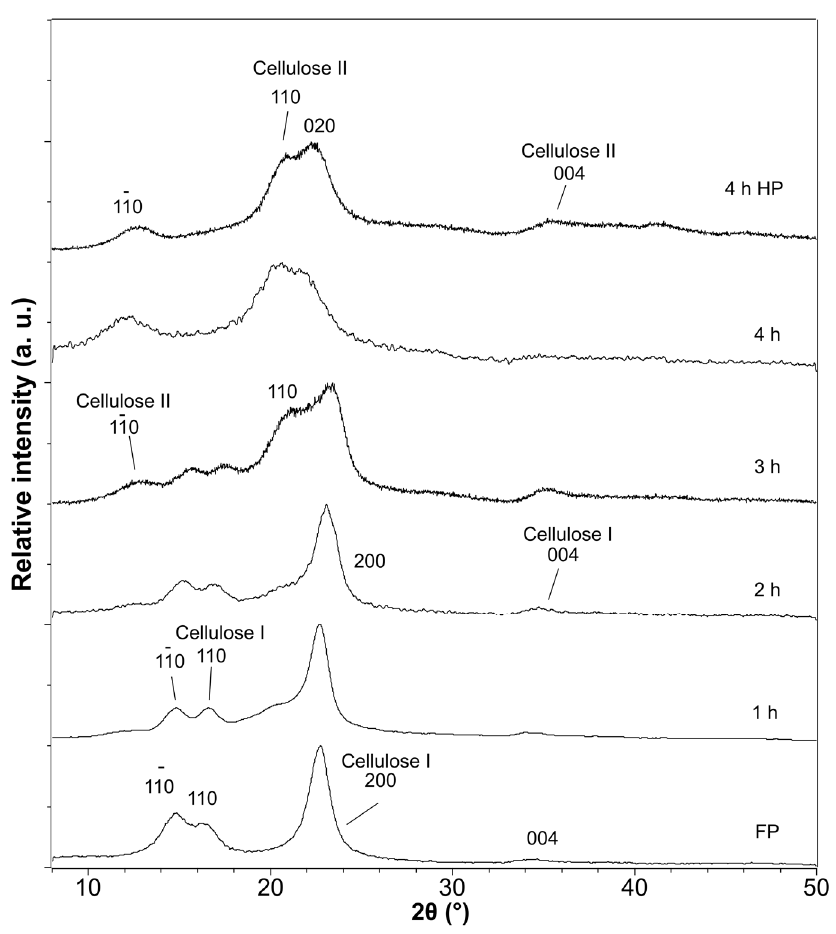
Figure 3. XRD diffractograms of filter paper (FP) and ACC samples treated with 7 wt% NaOH/12 wt% urea for 1, 2, 3, 4 h and 4 h HP (hot pressed). Miller indices are according to French [32].